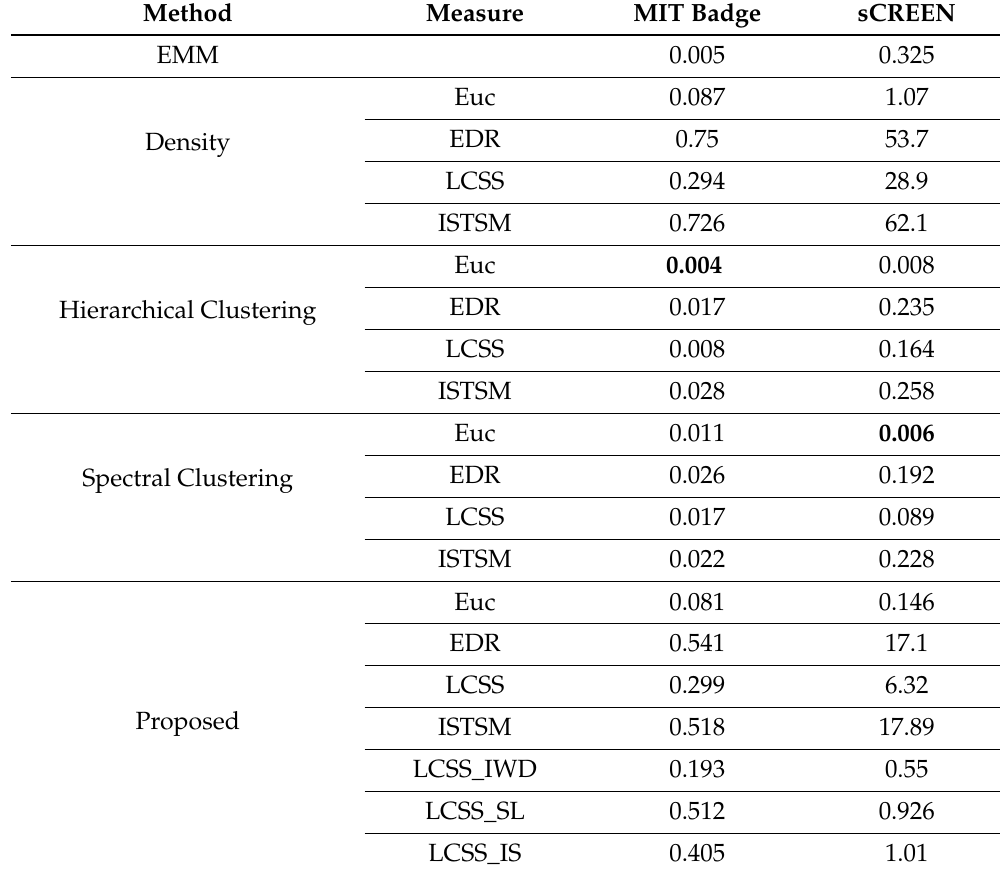
Table 7. Processing time for one trajectory